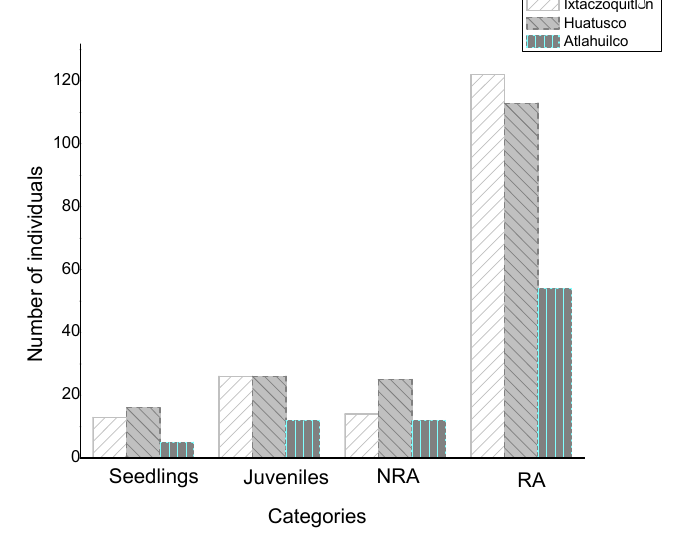
Figure 7. Sex and age population structure of three natural populations of V. tiliifolia in the central zone of the state of Veracruz. NRA: Non-Reproductive Adults. NA: Reproductive Adults.